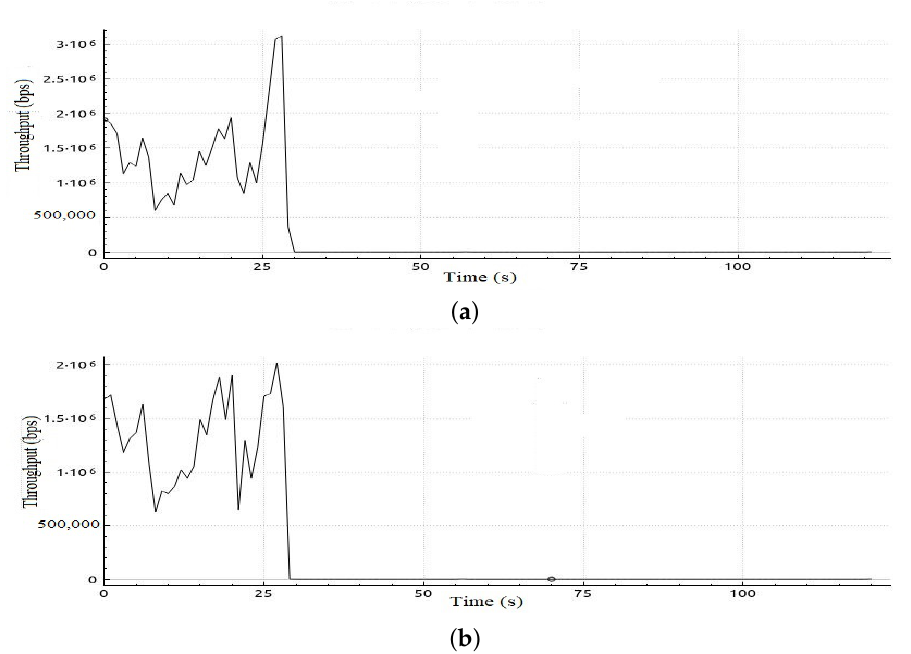
Figure 8. Throughput obtained in Scenario 1 in case of applying and without applying the proposed adaptive QoS model for 30-seconds video streaming traffic flow ( a ) Throughput obtained in Scenario 1 in case of applying proposed model, ( b ) Throughput obtained in Scenario 1 without applying the proposed adaptive QoS